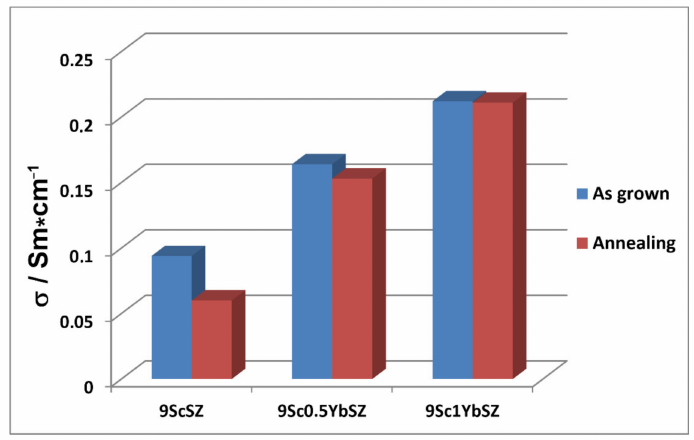
Figure 5. 1173 K conductivity of crystals as-grown and as-annealed at 1000 C for 400